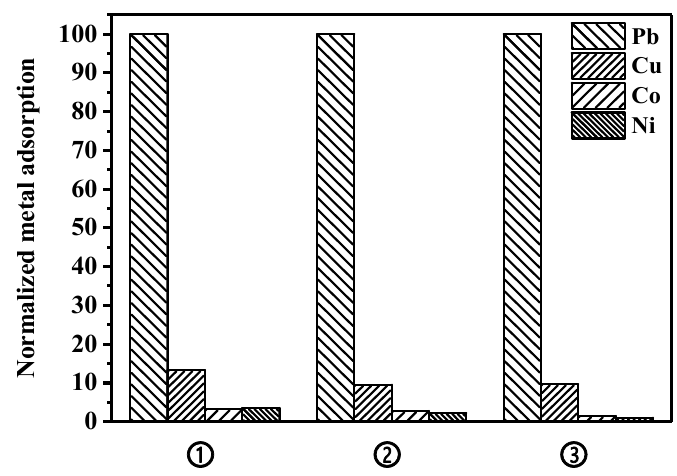
Figure 6. Comparison of the metal adsorption capacity in various conditions: ① single-metal solution; ② four-metal mixture solution; and ③ synthetic wastewater including four metal mixture.